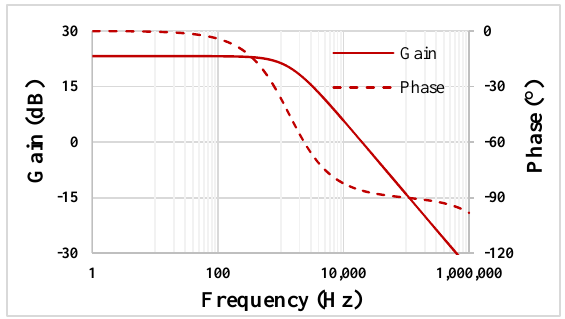
Figure 8. The gain and phase characteristics of the TA.